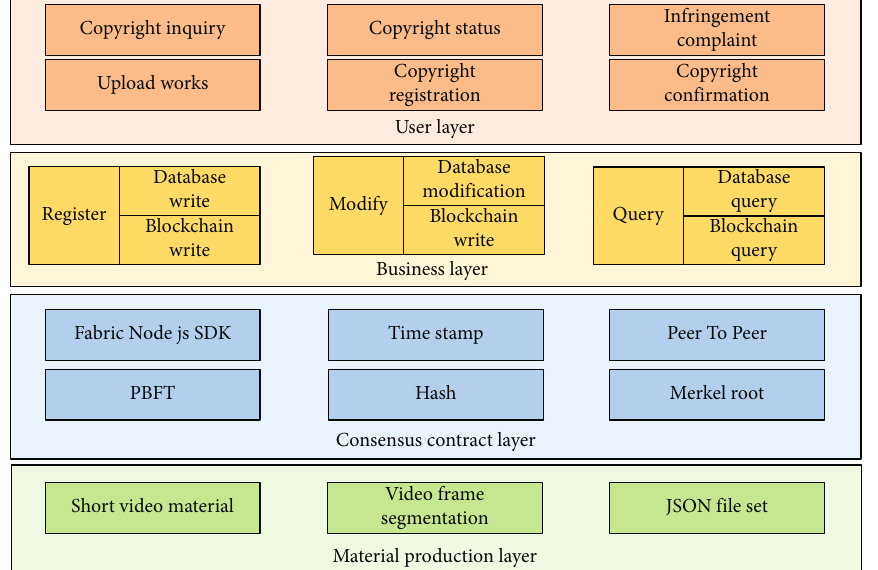
Figure 9: Architecture diagram.